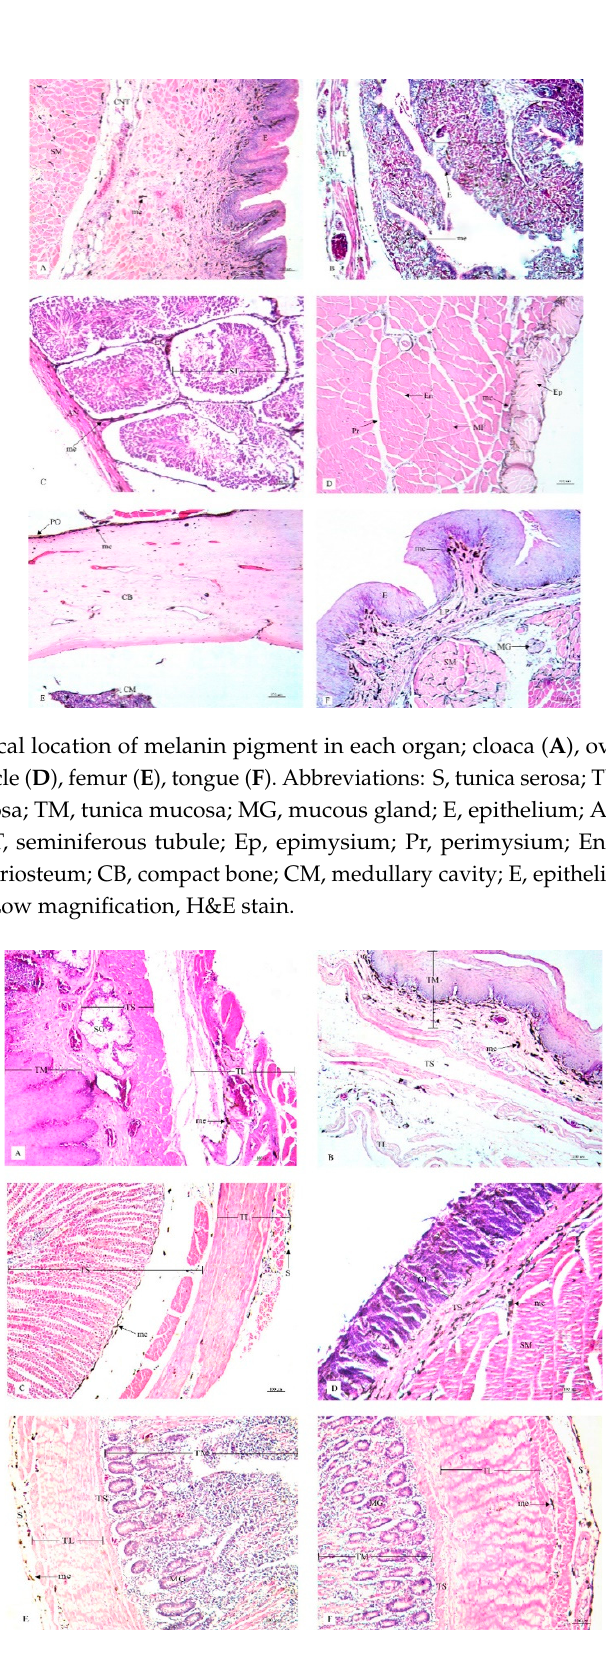
Figure 4. Histological location of melanin pigment in each organ; esophagus ( A ), crop ( B ), proventriculus ( C ), gizzard ( D ), duodenum ( E ), jejunum ( F ). Abbreviations: TL, tunica muscularis; TS, tunica submucosa; TM, tunica mucosa; SG, seromucous gland; S, tunica serosa; GL, granular layer; SM, muscular layer; MG, mucous gland; me, melanin pigment. Low magnification, H&E